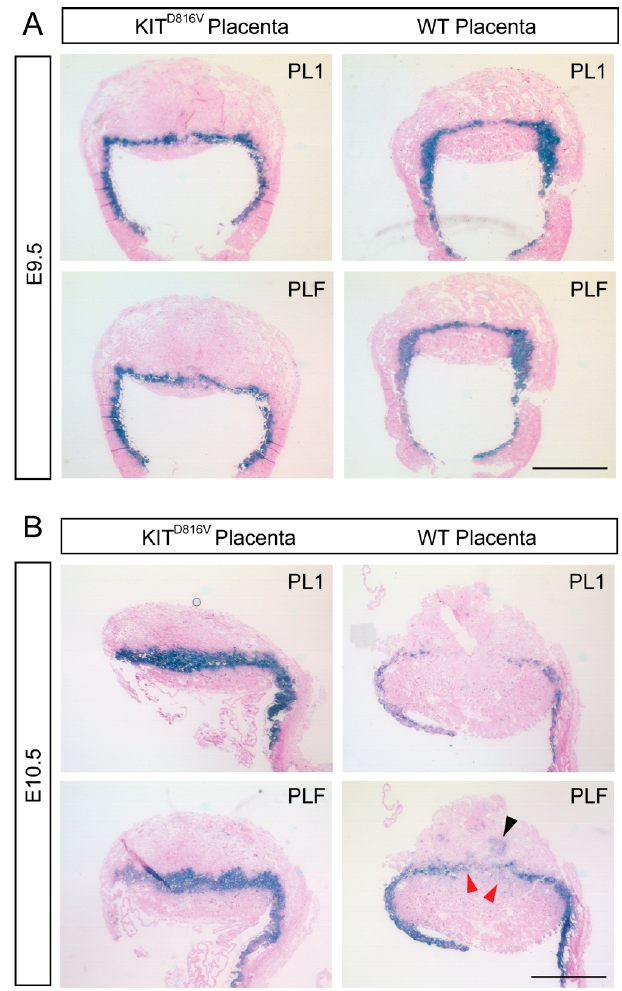
Figure 4. Increased levels of PL1 and PLF in KIT D816V placentas: ( A ) In situ hybridization of PL1 and PLF on paraffin sections of KIT D816V and control placentas at E9.5 using specific probe for PL1 and PLF (biological replicates = 2). Scale bar represents 1 mm. ( B ) In situ hybridization of PL1 and PLF on paraffin sections of KIT D816V and control placentas at E10.5 (biological replicates = 2): Red arrowheads indicate PL1 - /PLF + cells. Black arrowhead indicates invading Spiral Artery (SpA-)TGCs. Scale bar represents 1 mm.